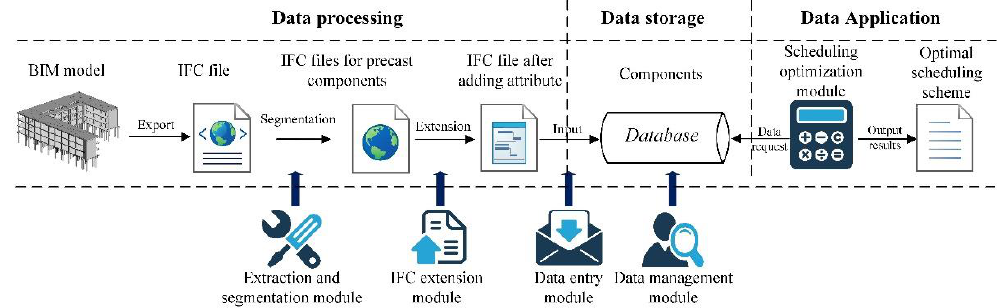
Figure 17. Building information modelling (BIM) information transfer flow chart.